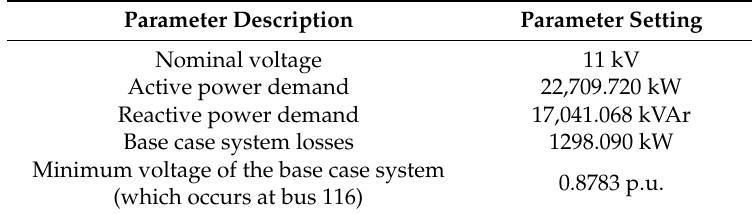
Figure 1. A schematic diagram of the 119-bus test system. Table 1. General system